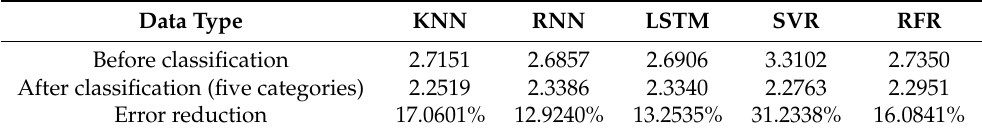
Table 2. Prediction error of data before and after